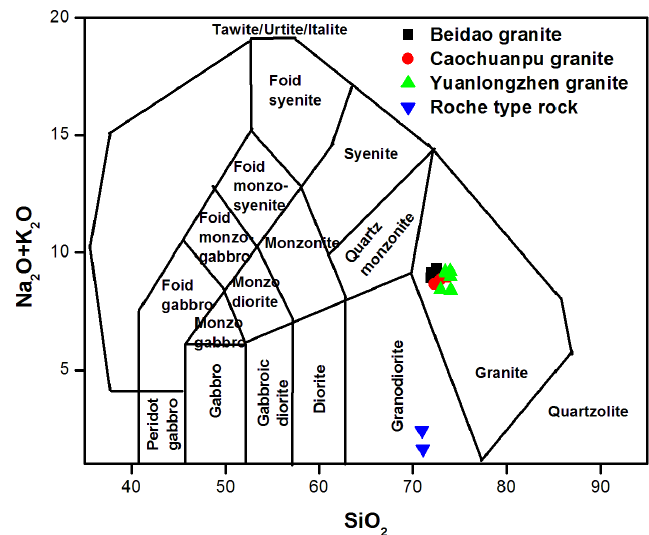
Figure 5. Total alkali-silica (TAS) classification diagram for granitoids. Note all the studied samples from the three granitoids show extremely similar chemical compositions except the Roche type rock that shows low alkali contents, diagram after [51].